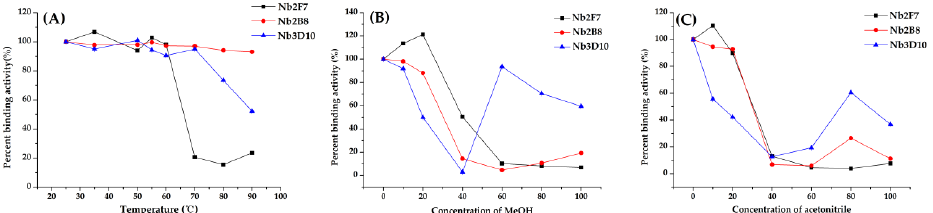
Figure 5. Thermostability and organic solvents tolerance of Nbs by ELISA based on the antigen 19-NT-OVA and anti- VHH-HRP antibody. ( A ) anti-19-NT Nbs (1 mg/mL) was incubated at 25, 35, 50, 55, 60, 70, 80 and 90 °C for 5 min. A series concentration (10%, 20%, 40%, 60%, 80% and 100%) of ( B ) MeOH, ( C ) acetonitrile.